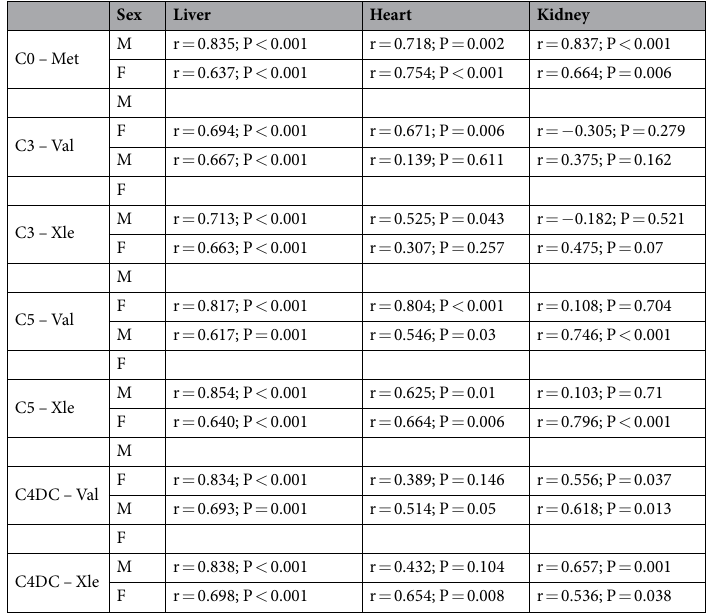
Table 1. Analysis of correlations among levels of carnitines and amino acids in male (M) and female (F) rat organs. The Spearman Product Moment Correlation coefficient (r) and the P value are reported for each tissue and